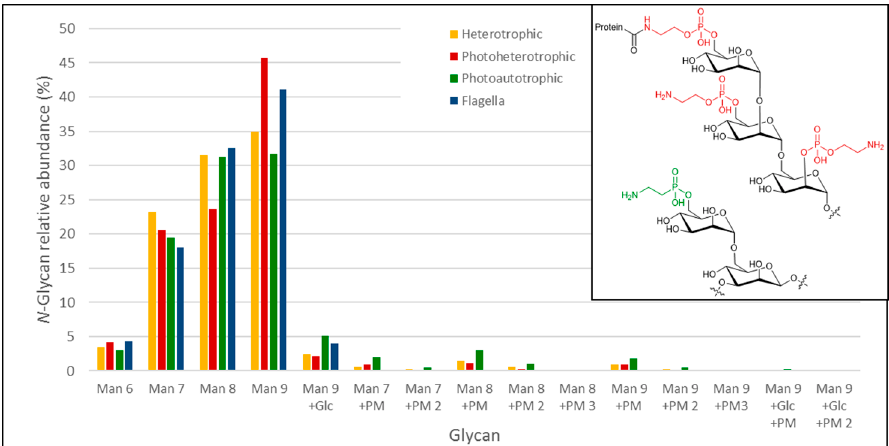
Figure 5. N -glycans found on Euglena (glyco)protein extracts and on purified flagella. For each measurement, the obtained values are normalised to the sum of all detected N -glycans. PM-glycan modification. The inset shows a fragment of the structure of a human GPI anchor core (upper) [38] and a fragment of a Locusta migratoria N -glycan (lower) [33]. The aminoethylphosphate and aminoethylphosphonate are highlighted in red and green respectively. Table 1. N -glycans identified in Euglena by PGC-LC-ESI-MS/MS.